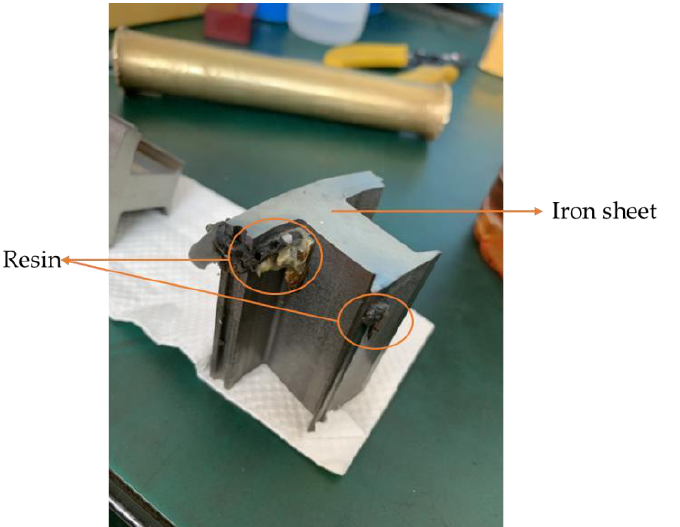
Figure 12. Schematic diagram of bumps caused by resin overflow.